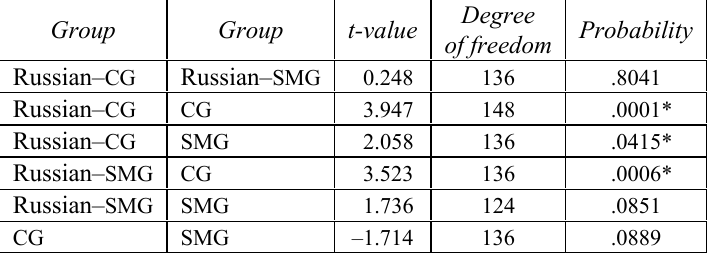
Table 5: ANOVA statistical analysis